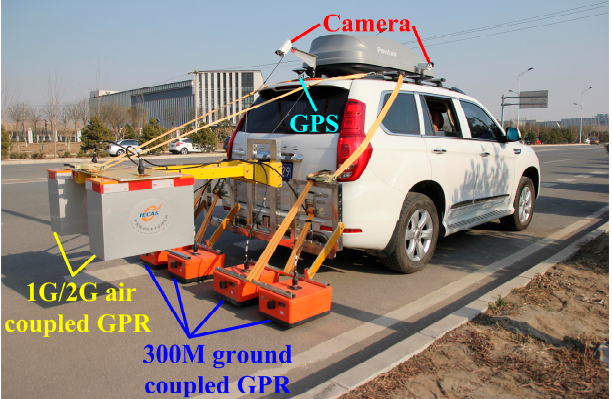
Figure 1. The appearance of the vehicle-mounted GPR detection system.